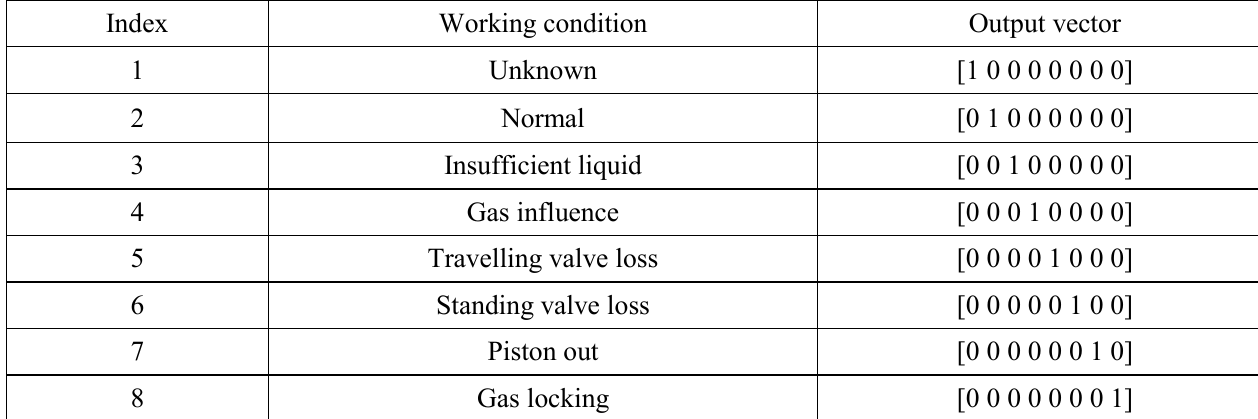
Table 1—Ideal output mode for CNN